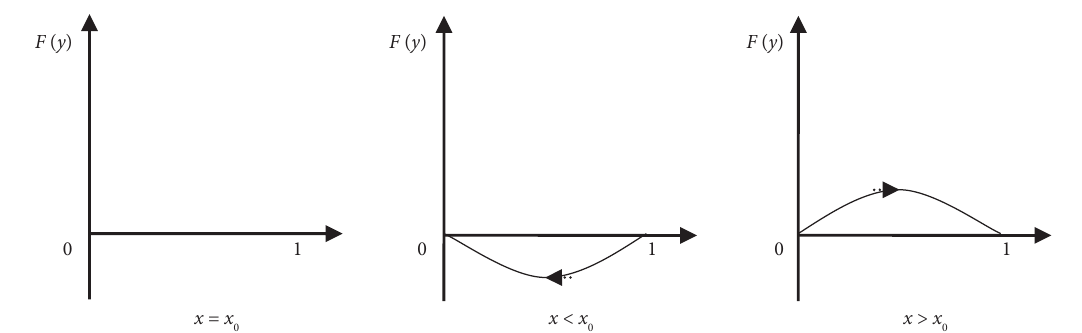
Figure 2: Replicated dynamic phase diagram of the platform